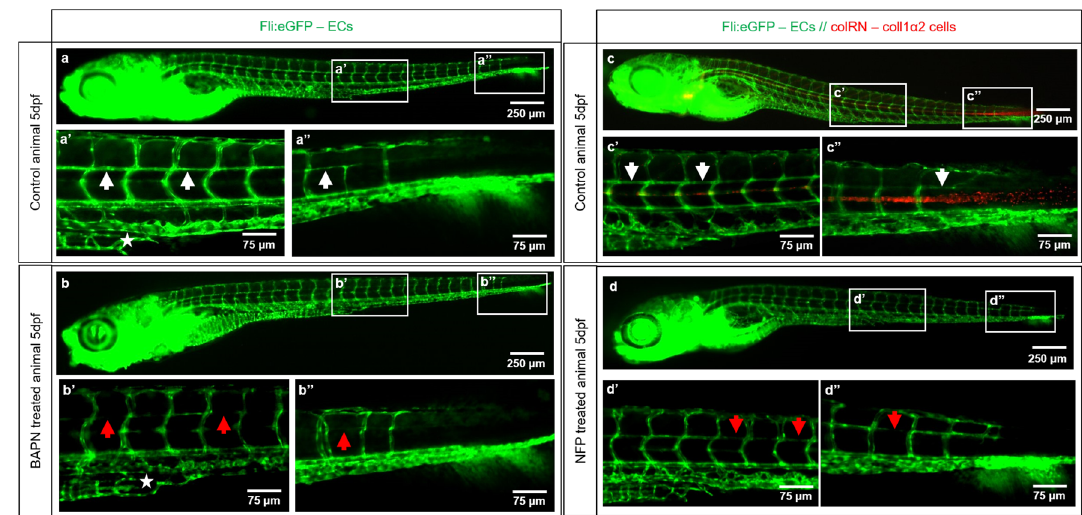
Figure 9. Collagen cross-linking inhibition and reduced collagen 1α2 impair blood vessel formation. Vascular development (ECs - green) in the zebrafish embryo at 5dpf in a control animals ( a , a’ , a’’ and c , c’ , c’’ ) versus BAPN-treated ( b , b’ , b’’ ) and NFP-treated ( d , d’ , d’’ ) animals is documented. a’ / a’’ shows normal caudal plexus formation with horizontal capillaries connecting the intersegmental vessels (ISV; a’ , a’’ , white arrow) and subintestinal vein (SIV) ( a’ , asterisk). The BAPN-treated animals show an underdeveloped plexus with absent SIV ( b’ , asterisk) and an impairment in the formation of capillaries connecting ISV ( b’ , b’’ , red arrows). c – c’’ show normal caudal plexus formation with capillaries connecting ISV (white arrows) and multiple active cells producing collagen 1α2 (in red). Upon NFP treatment, active collagen 1α2 producing cells are absent ( d – d’’ ) and the formation of horizontal capillaries connecting the ISV is impaired ( d’ , d’’ , red arrows). ISV - intersegmental vessels, SIV - subintestinal vein; images are acquired by fluorescent reflected light